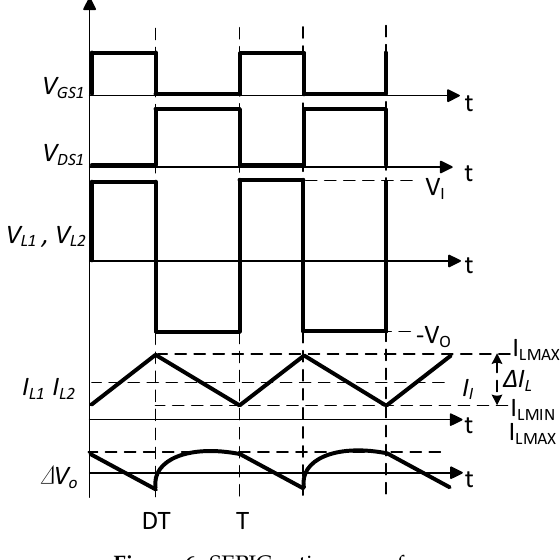
Figure 6. SEPIC action waveform.